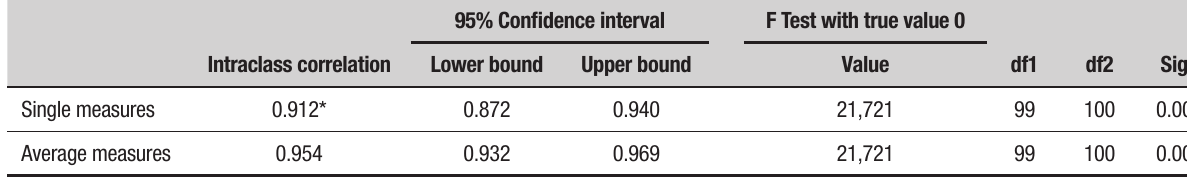
Table 4. Intraclass correlation coefficient.